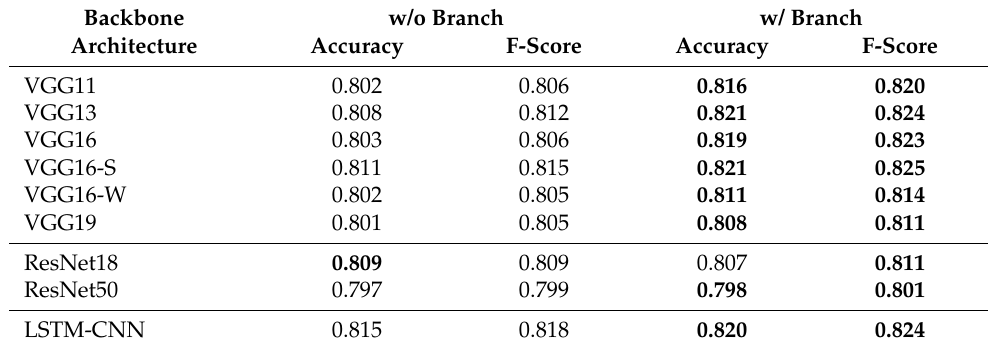
Table 3. Comparison of estimation accuracy for B-CNNs of different backbone architecture.